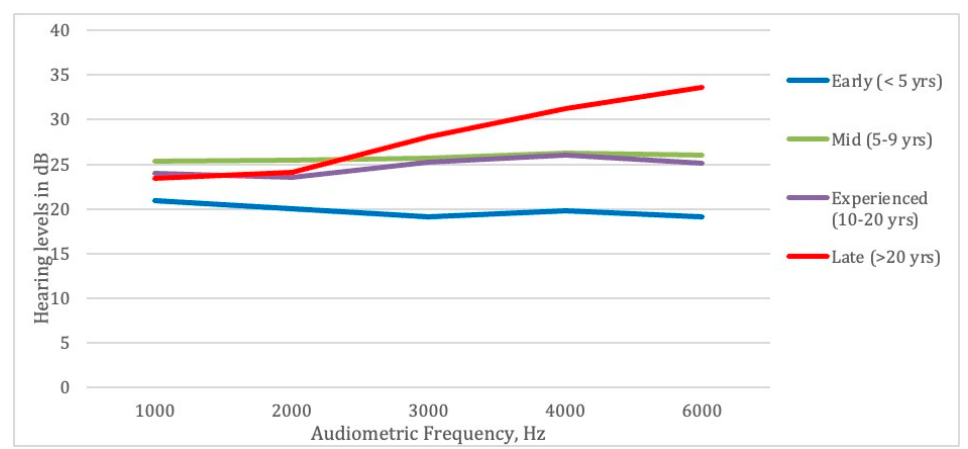
Figure 3. HTLs in worst ear at all tested frequencies by years worked in the fire service.